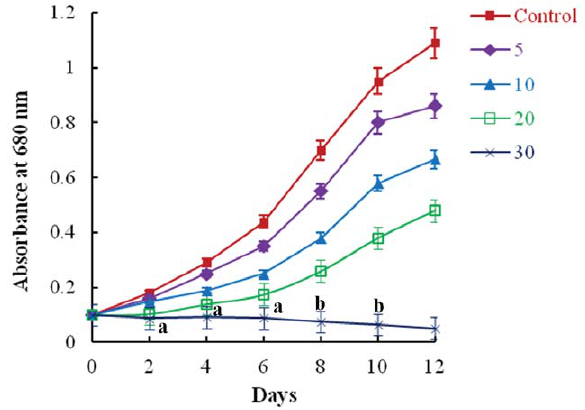
Figure 1. Growth of Synechocystis sp. strain PUPCCC 64 in basal medium supplemented with anilofos (mg L 2 1 ). All presented data are the mean values of three independent experiments 6 SD Data at different time intervals with same lower case letters are not significantly different from each other at the 95% confidence level (p , 0.05).